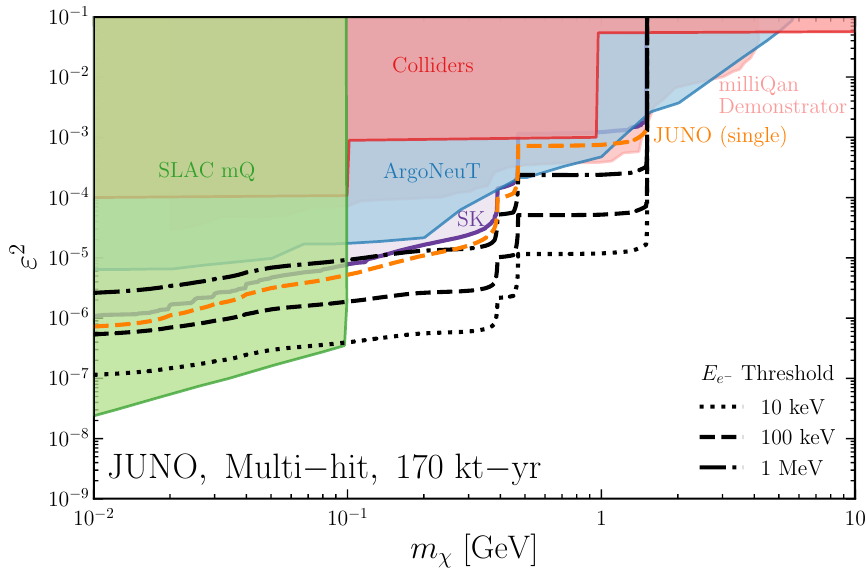
Figure 9 . Multiple-hit constraints on millicharged particles from JUNO. Black: expected 90% CL sensitivity to millicharged parameter space using the multiple hit strategy of JUNO and a 170 kt-yr exposure. Three different assumptions about the minimum observable electron recoil energy are assumed: 10 keV (dotted), 100 keV (dashed), and 1 MeV (dot-dashed). Existing constraints (including our Super-Kamiokande analysis in purple) are shown as filled in regions, and the single-hit analysis of JUNO from figure 7 is shown as a dashed orange